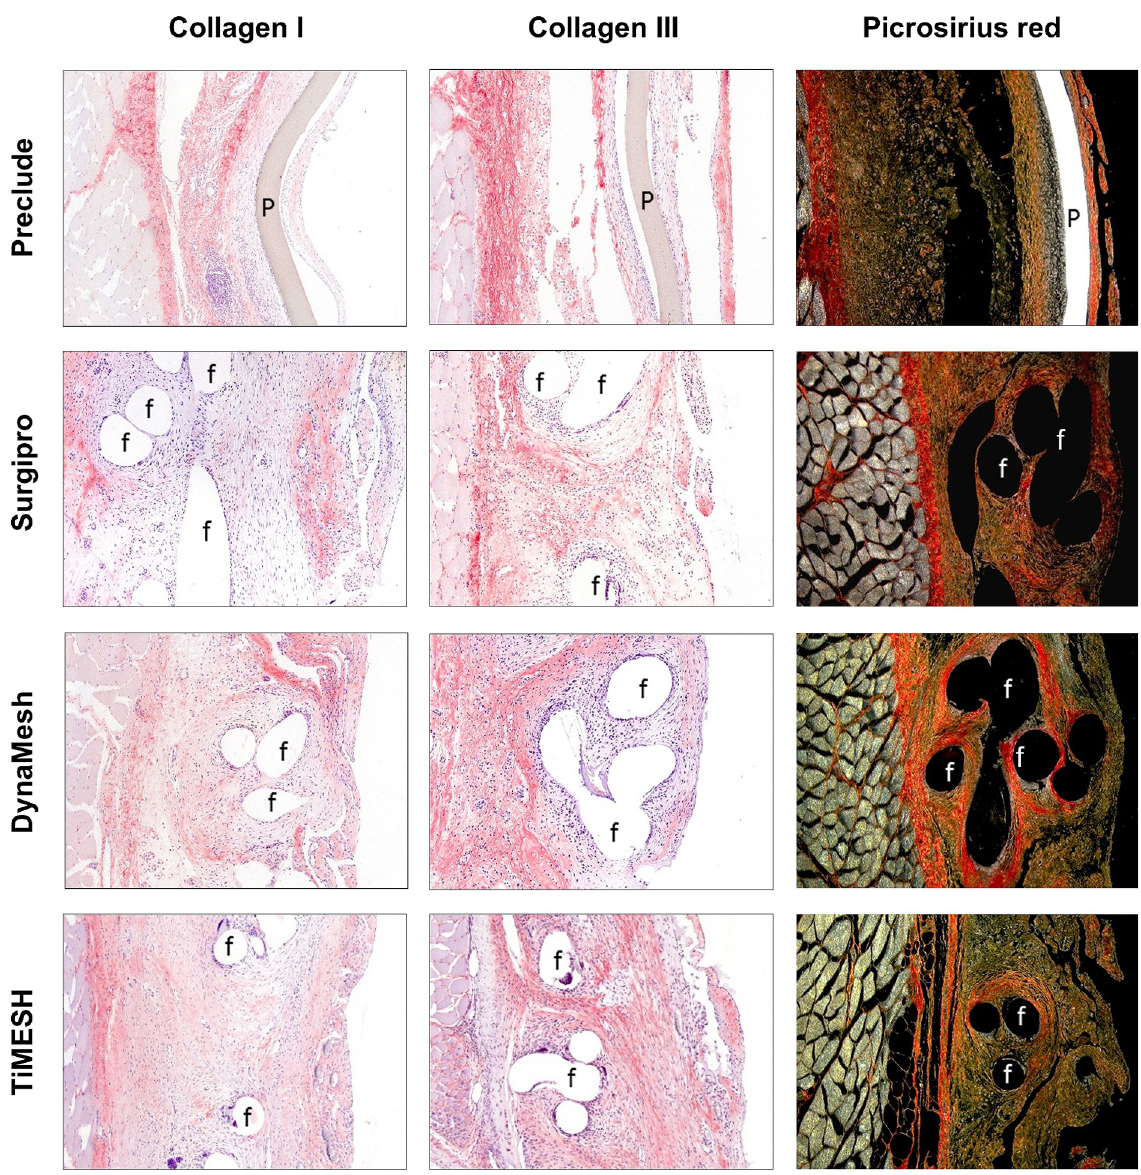
Fig 6. Collagen expression. Immunolabeling for collagens type I and III and Picrosirius red staining in implants from the different study groups (100x magnification). f: mesh filaments, P: Preclude.